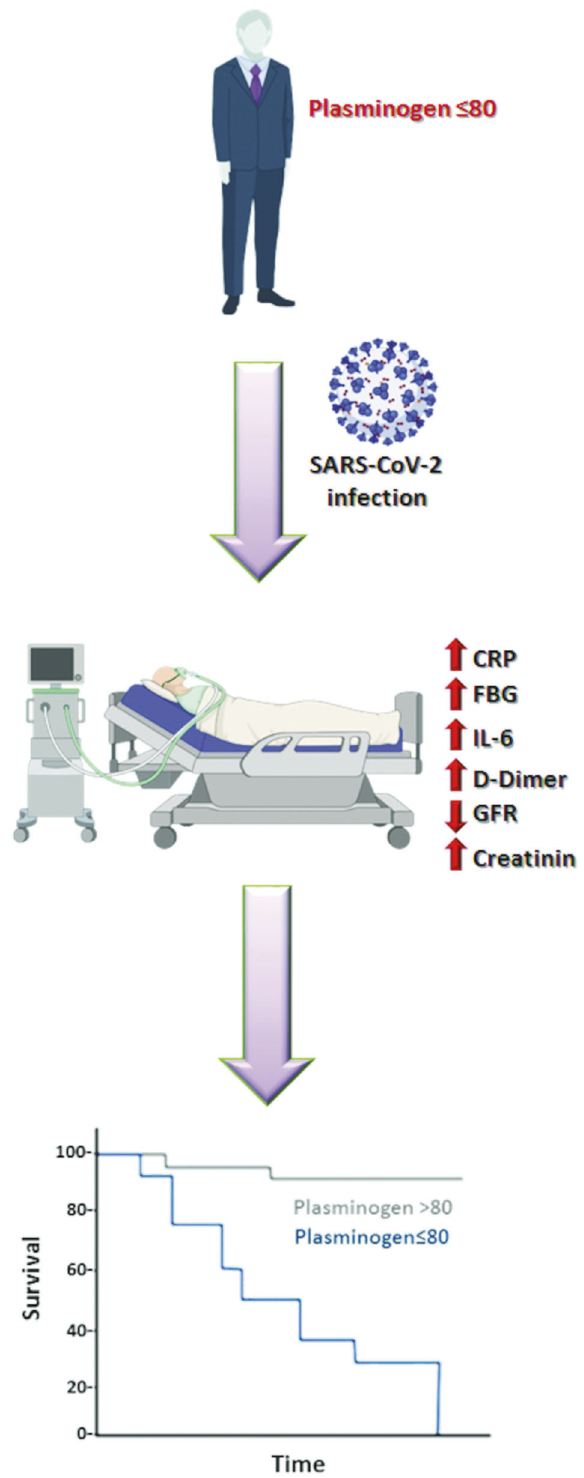
Fig. 3 Schematic representation of COVID-19 impact on subjects with lower levels of plasminogen. Subjects with plasminogen ≤ 80 showed poor prognosis following SARS-CoV-2 infection due to alteration in several in fl ammatory and coagulation-related para- meters. CRP C reactive protein, FBG fasting blood glucose, IL-6 interlukin-6, GFR glomerular fi ltration rate. Created by BioRender. com.